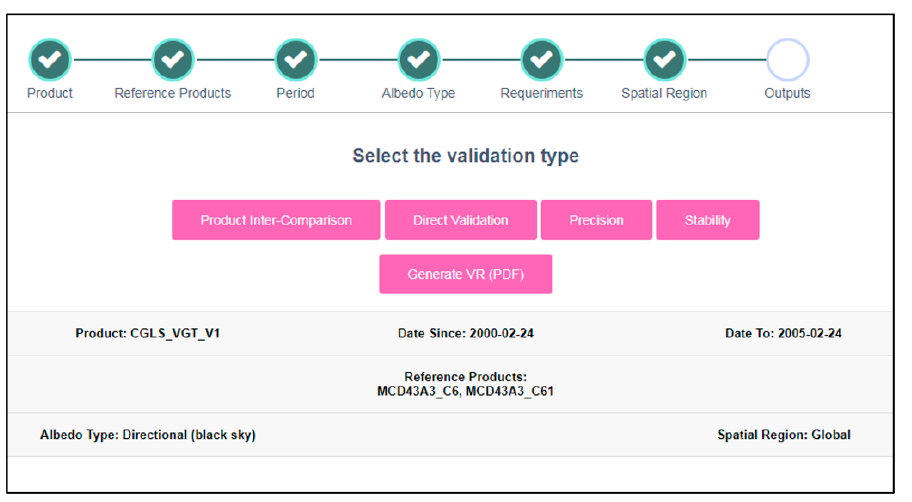
Figure A4. Snapshot of SALVAL configuration step 4.